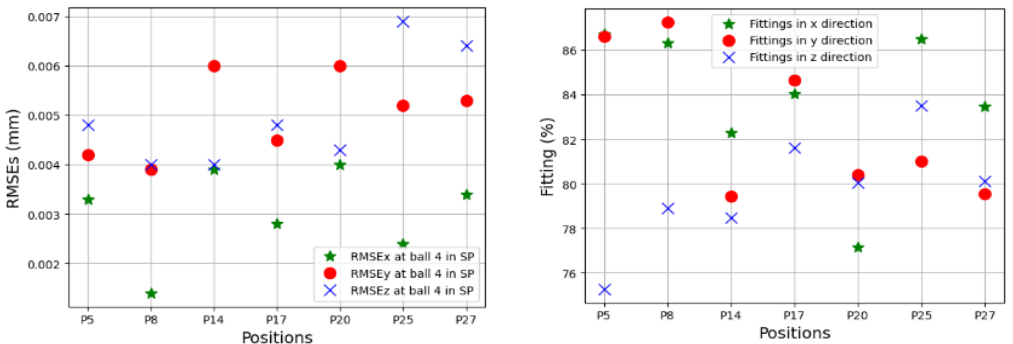
Figure 24. RMSEs and fi tt ings of seven positions at ball 4 in the short process (SP).